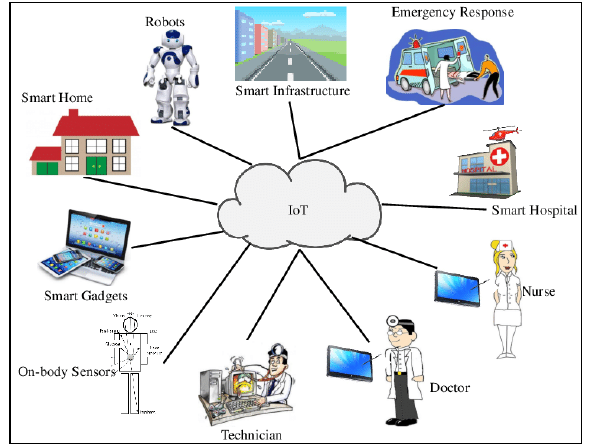
Figure 2: IoT on Smart Health System